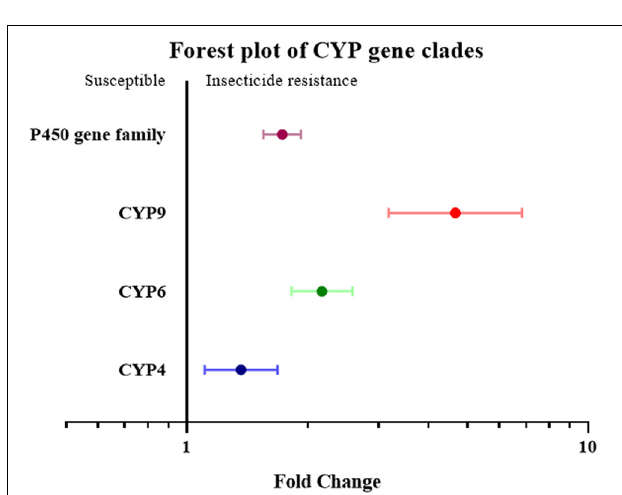
FIGURE 3 | Meta-analytical, sub-group estimate of gene expression related to insecticide resistance, with 95% CI in the P450 gene families classified by gene clade. The overall effect represents the collective effect of all P450 studies.